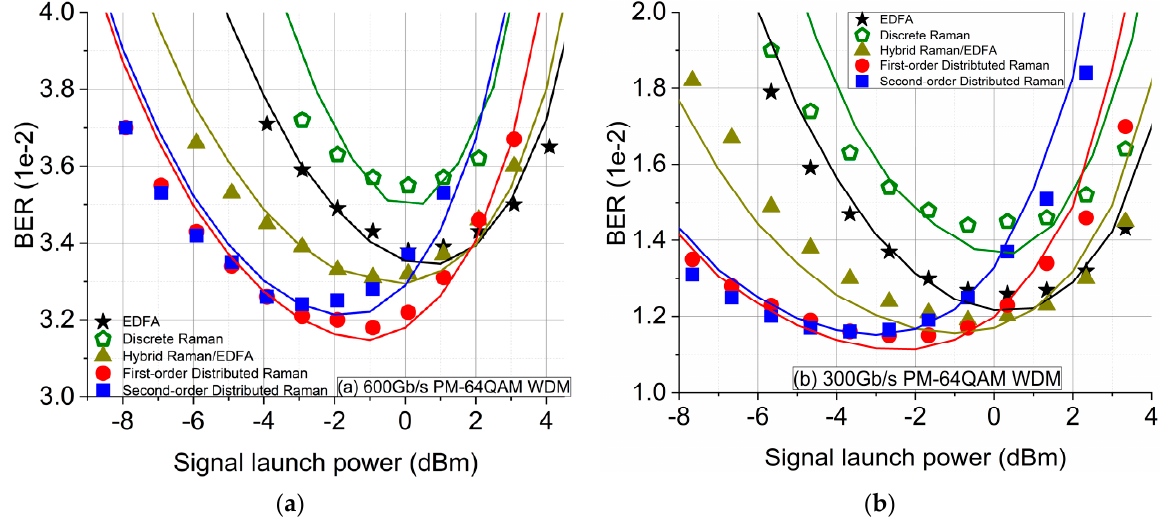
Figure 4. Simulated and experimental BER performances over a 75.6 km SMF with different amplification schemes measured at the centred channel (at 1547.72 nm): ( a ) 600 Gb/s PM-64QAM WDM transceiver; ( b ) 300 Gb/s PM-64QAM WDM transceiver.